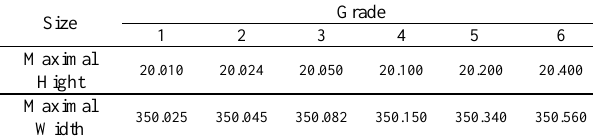
Table 1. The maximum outline size of pothook (mm) Size